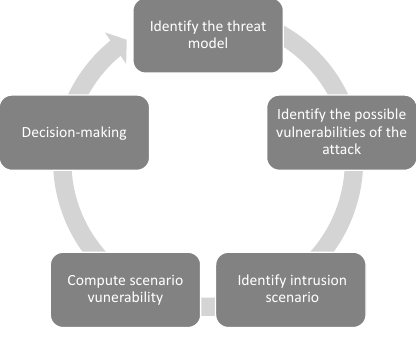
Figure 1. Procedures of vulnerability assessment of cybersecurity for critical infrastructures In order to evaluate vulnerability indices